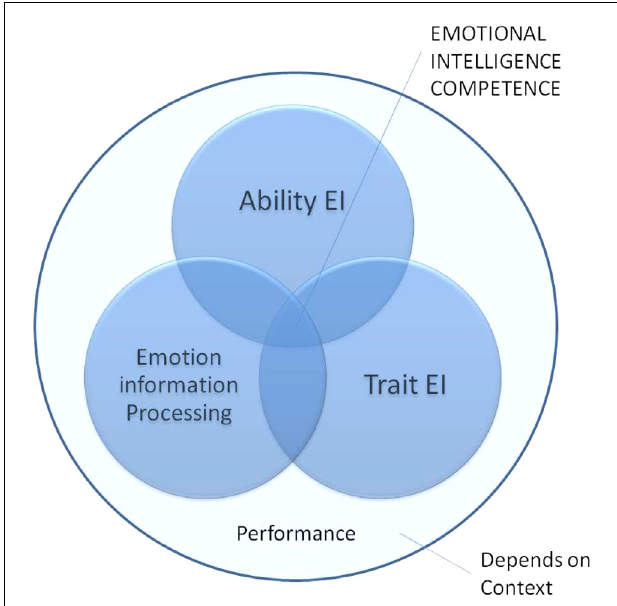
FIGURE 1 | PAT Integrated Framework for the prediction of EI